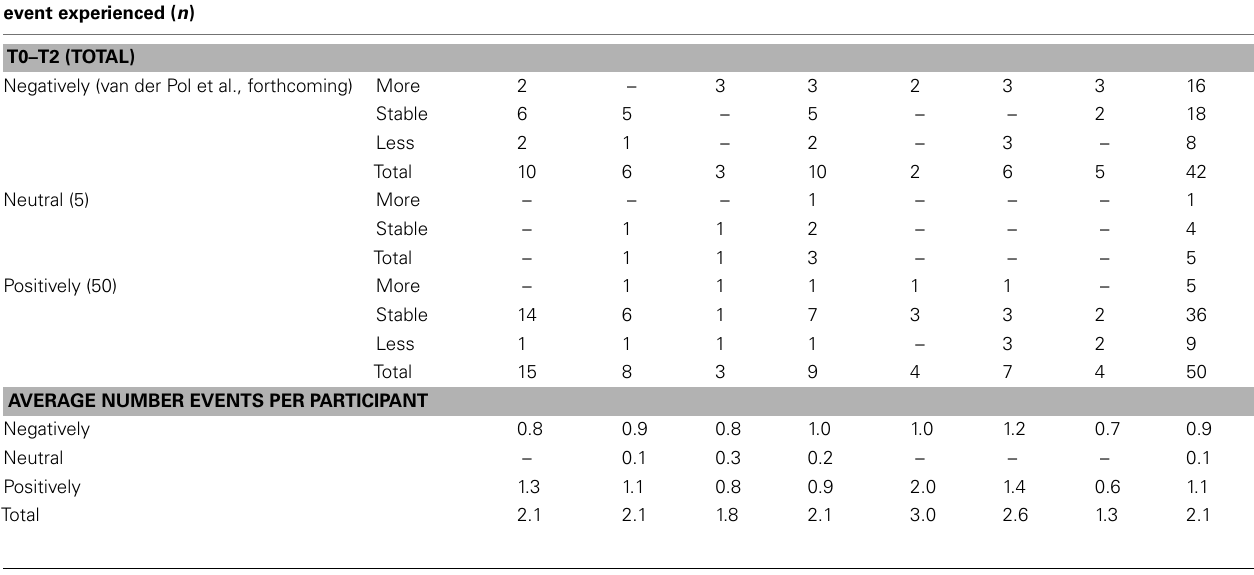
Table 2 | Events related to study or